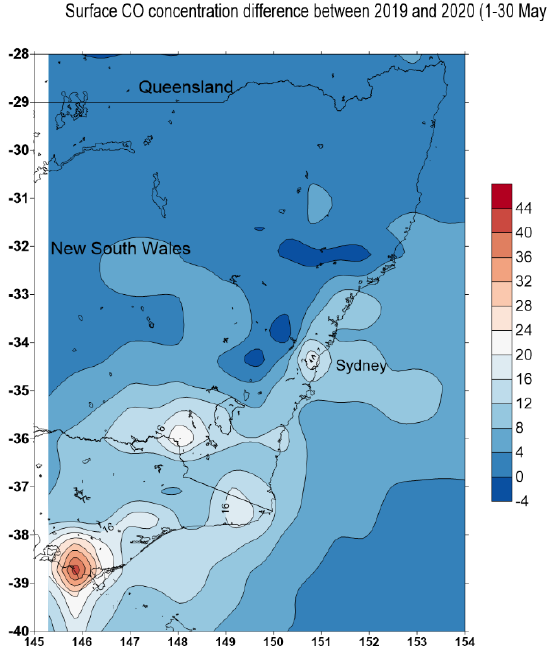
Figure 5. Monthly averaged map of CO surface concentration (ENSEMBLE) monthly 0.5 × 0.625° [MERRA-2 Model M2TMNXCHM v5.12.4]. The unit is in parts per billion volume (PPBV) (data source: NASA Giovanni online https://giovanni.gsfc.nasa.gov/. Accessed on 27 March 2021).